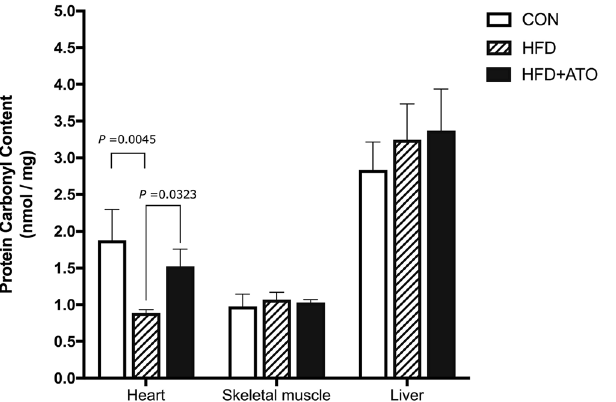
Figure 7. Protein Carbonyl content (PCC) (marker of oxidative stress) measured by fluorometry in heart muscle, skeletal muscle and liver from control (CON), obese (HFD) and obese atorvastatin treated Göttingen Minipigs (HFD + ATO). In heart muscle, PCC was significantly higher in the HFD + ATO group compared to the HFD group ( P = 0.0323). No significant differences in PCC were found between the groups in skeletal muscle and liver. Bars and error bars denote means ± SEM, n = 6–7 in each